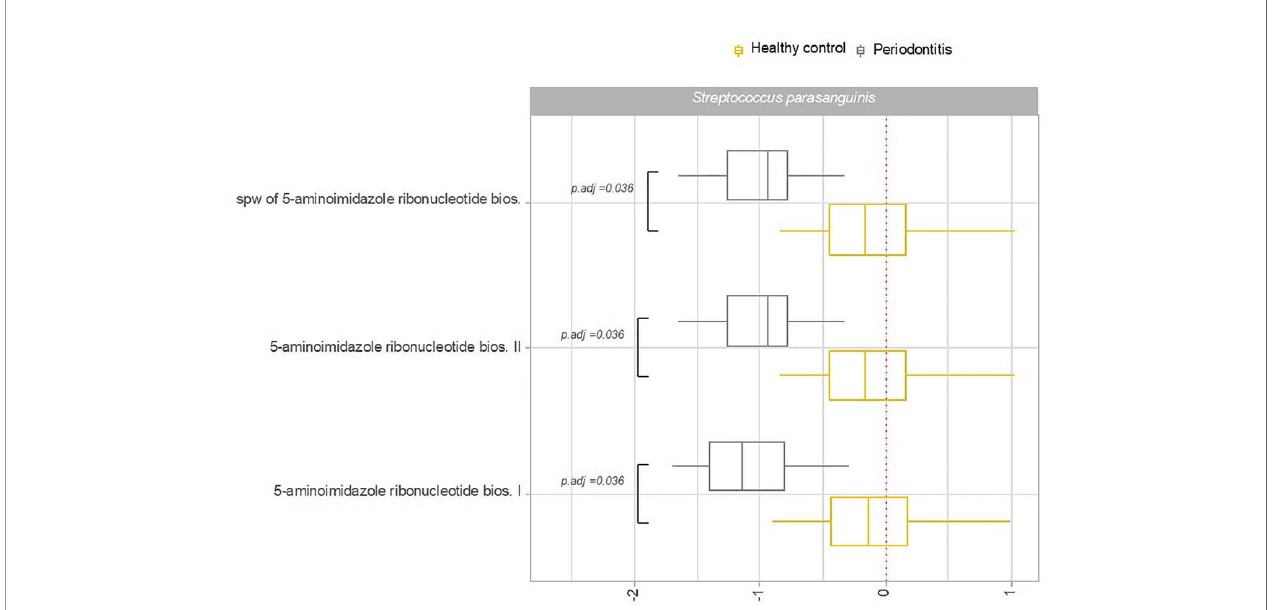
FIGURE 7 | Pathway expression of Streptococcus species in tongue bio fi lm in periodontitis versus oral health. Pathways identi fi ed with signi fi cantly different log2 (RNA/DNA) in tongue bio fi lm from patients with periodontitis versus oral health with each dot representing a speci fi c sample. Streptococcus parasanguinis . Boxplots display fi rst and third quartiles, median. Whiskers display 1.5 * IQR. Color coding: yellow: healthy control, grey: